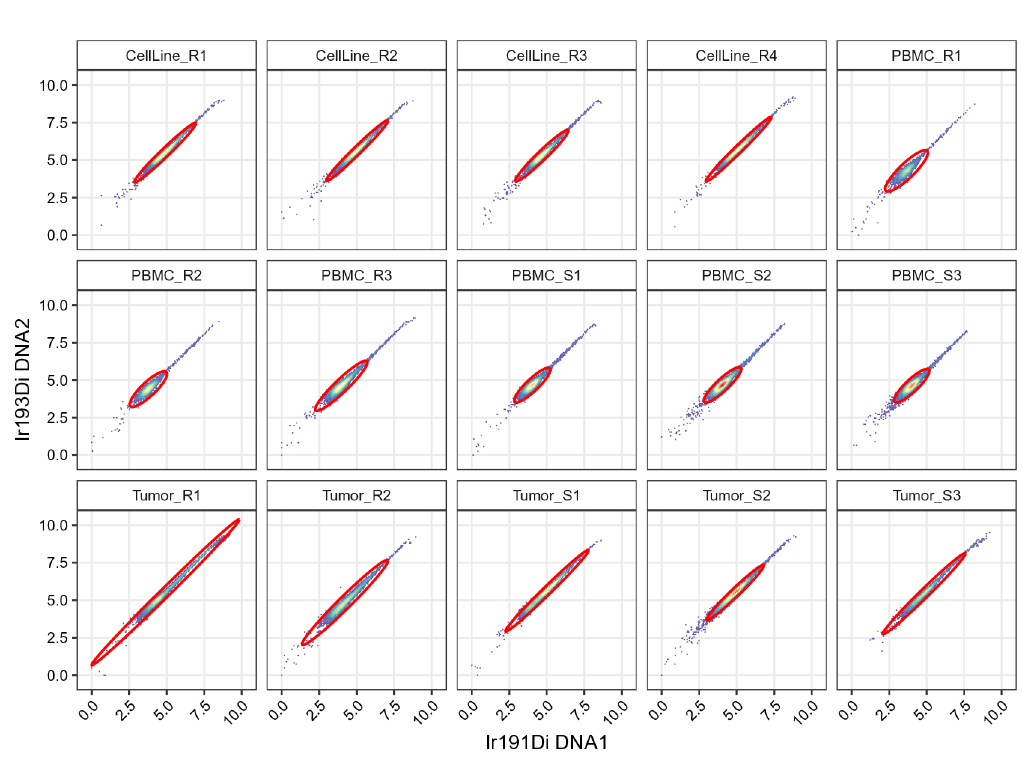
Figure 10. Scatter plots of DNA channels, split by sample and including elliptical cell